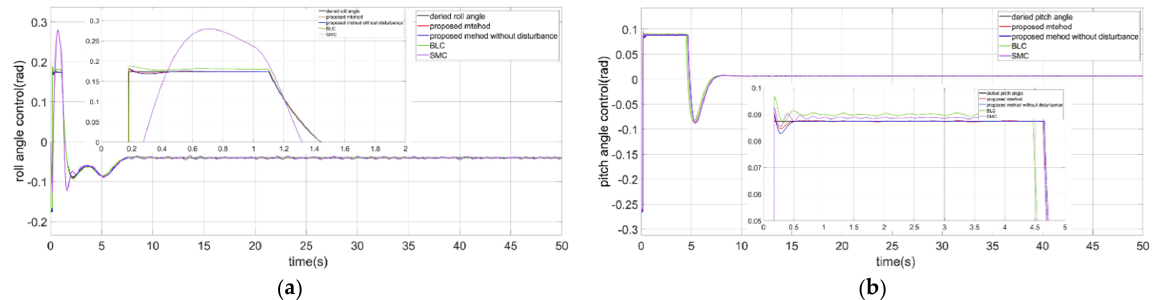
Figure 20. The control results of the roll angle and the pitch angle. ( a ) The control results of the roll angle. ( b ) The control results of the pitch angle.